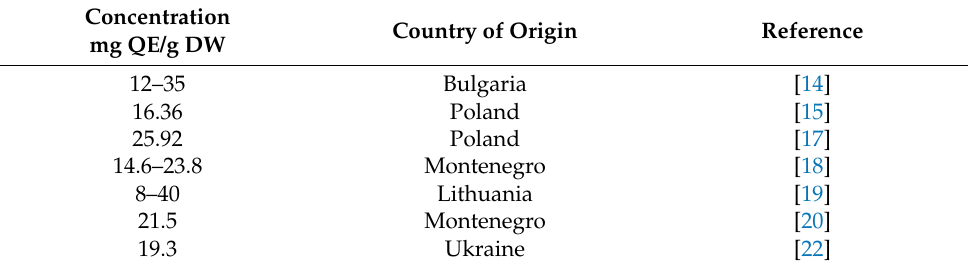
Table 2. Total flavonoid content reported in different